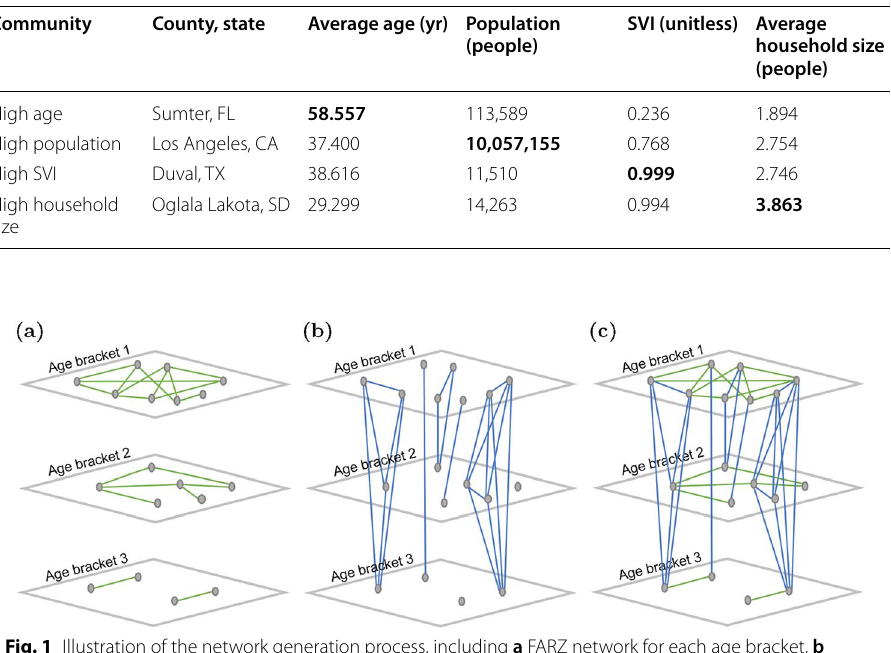
Fig. 1 Illustration of the network generation process, including a FARZ network for each age bracket, b household clusters, and c the combined network. Gray nodes represent people, green and blue edges indicate connectivity between people. Age bracket 1 has 8 people with an average node degree of 5, age bracket 2 has 6 people with an average node degree of 4, age bracket 3 has 4 people with an average node degree of 3. There are 7 households, with an average household size of 2.6 (2 households contain 1